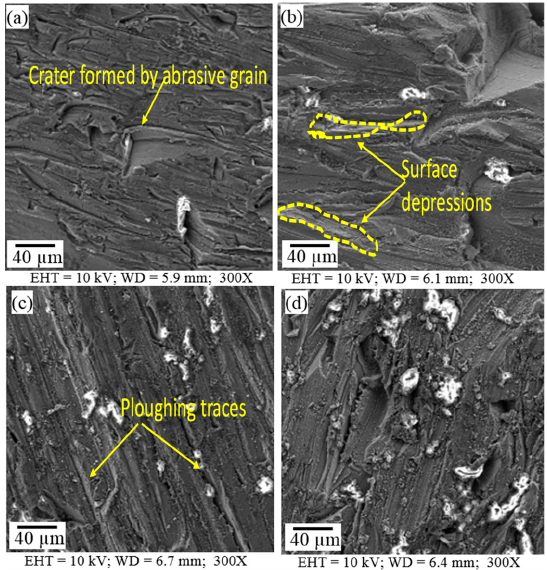
Figure 5. Surface morphological images of samples ( a ) B1; ( b ) B2; ( c ) B3; ( d ) B4 showing machined surface characteristics . Variations in the surface along the depth of Mg-6Al/0.66 and Mg-6Al/1.11 Al 2 O 3 sam- ples are depicted in Figures 6 and 7, respectively. The Mg-6Al/0.66 surface at the top of the specimen has numerous traces of abrasive flow, and many slightly curved longer and shorter lines in the direction of flow and a few medium-sized lines across the flow are evident. The longer lines are very distinct and spaced relatively far apart. The surface of the middle area of the sample is quite similar to that of the top area, but the longer lines are more densely packed. The surface of the bottom area of the sample is different to that of the top and middle areas. In this case, AWJ machining generates many randomly ori- ented distinct short lines on the surface. In addition, the bottom area of the machined sur- face, i.e., the jet exit region, appears to have many grooves and slots, which can be at- tributed to jet spreading or the non-uniformity of abrasive distribution in the jet. The surface characteristics of Mg-6Al/1.11 Al 2 O 3 are similar to those of Mg-6Al/0.66 Al 2 O 3 . In this case, the top region has many straight and curved lines, which are densely packed. The randomness of these curves on the surface increases towards the bottom of the sample. This is attributed to the loss of the hydraulic energy of the jet, which is neces- sary to overcome the resistance provided by the material with the increase in the width of the sample. Therefore, on the exit side, the surface roughness and randomness of the abra- sive traces increase.